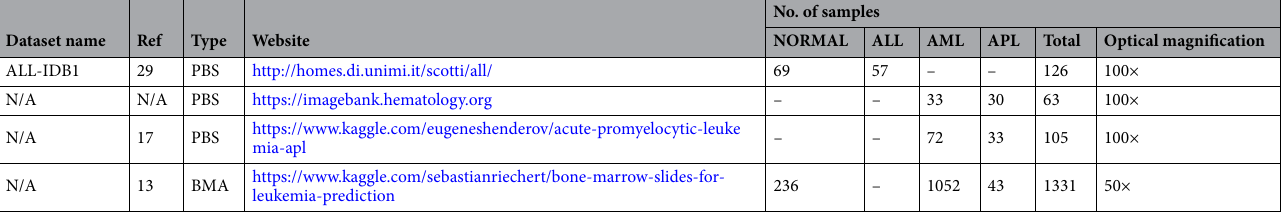
Table 1. Image datasets with diagnostic level labels used to train and test MILLIE. PBS peripheral blood film, BMA bone marrow aspirate.